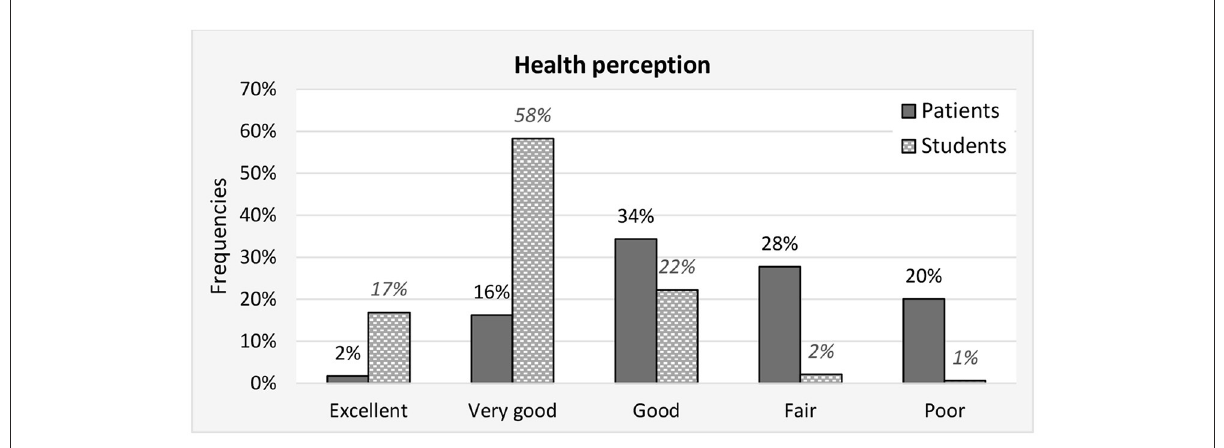
FIGURE3 Health perception - frequencies of answers for patient and student groups.